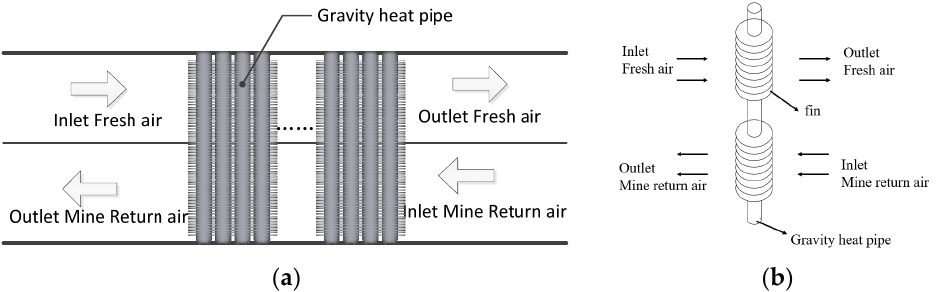
Figure 1. The heat transfer model of a gravity heat pipe: ( a ) heat transfer principle for the gravity heat pipe; ( b ) the structure of a gravity heat pipe.